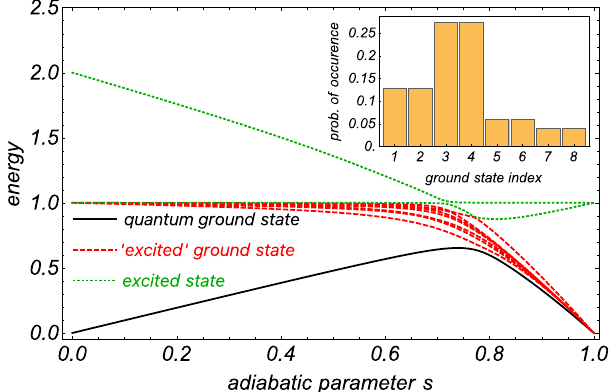
Figure 1. Ten lowest energy levels of an 8-qubit Hamiltonian interpolating between a transverse field driver Hamiltonian and a randomly generated Ising Hamiltonian. The solid black line indicates the energy of the instantaneous ground-state. The dashed red and dotted green lines indicate excited states that lead to final ground-states and final excited states, respectively. Inset: The probabilities for obtaining the various classical ground-states upon measuring the quantum ground-state at the end of the evolution in the computational